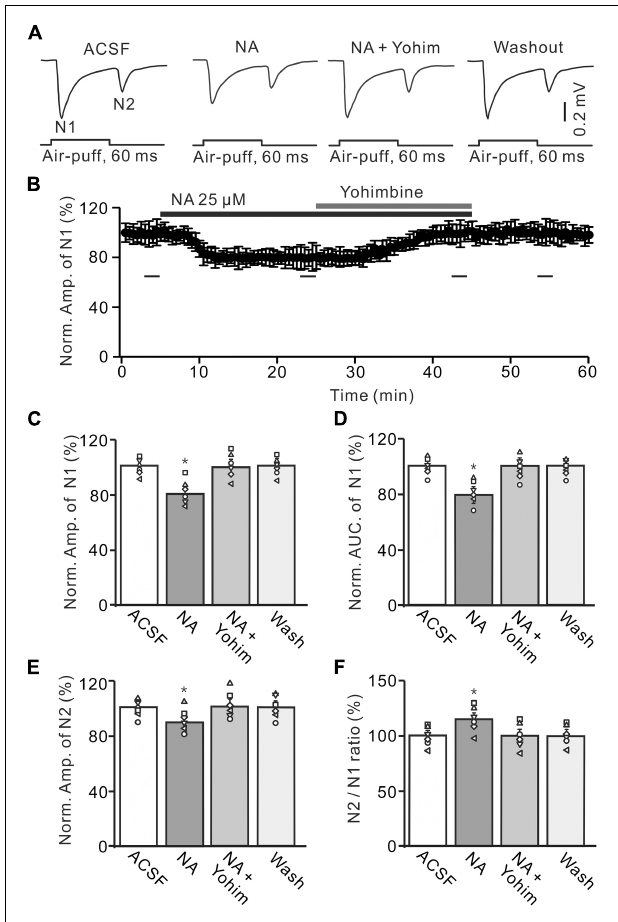
FIGURE 5 | Application of yohimbine reverses the NA-induced depression of the MF-GC synaptic transmission. (A) Representative field potential traces showing the facial stimulation (60 ms, 60 psi) evoked responses in a mouse cerebellar GL during treatment with ACSF, NA (25 µ M), NA + yohimbine (Yohim; 100 µ M), and recovery (washout). (B) Summary of data ( n = 6) showing the time course of normalized amplitude of N1 during treatment with ACSF, NA, NA + yohimbine (Yohim; 100 µ M) and recovery (washout). (C,D) Bar graphs with individual data showing show the normalized amplitude (C) and AUC (D) of N1 during each treatment. (E,F) Mean value ( ± SEM) with individual data showing the normalized amplitude of N2 (E) and the N2/N1 ratio (F) during each treatment. * p < 0.05 versus control (ACSF); n = 6 in each